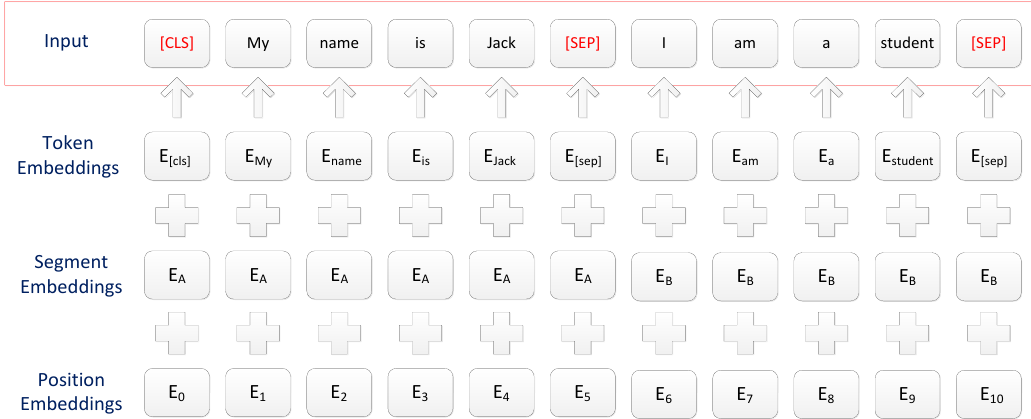
Figure 2. BERT input representation [16].